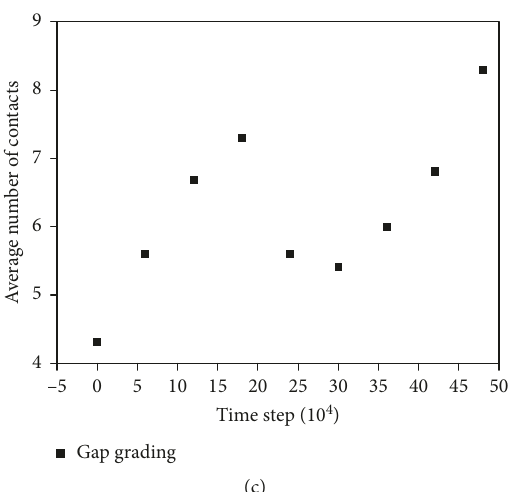
Figure 19: Variation of the average coordination numbers with different penetration displacements (a) S � 6 mm, (b) S � 12mm, and (c) S � 20mm.